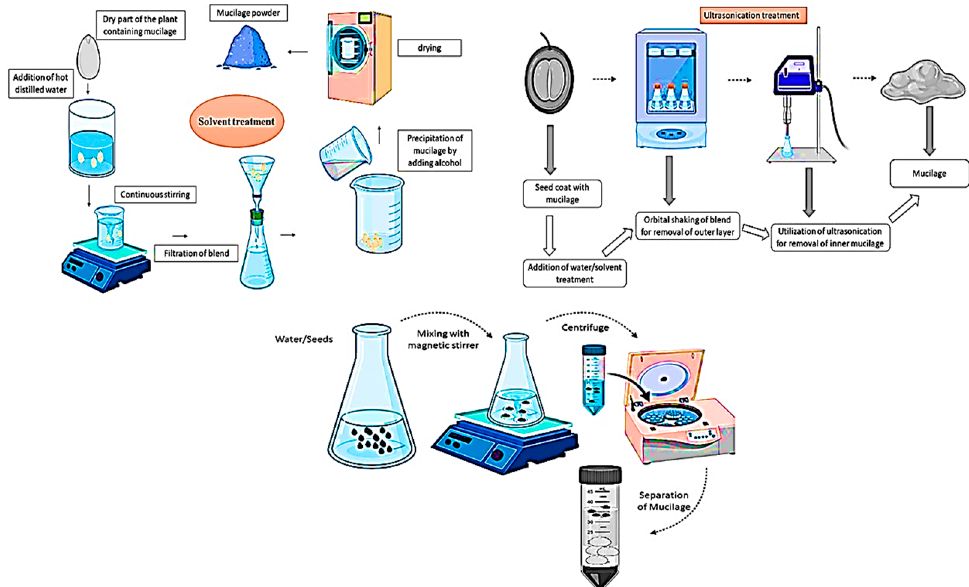
Figure 1. Extraction of mucilage from plant parts using solvent extraction, microwave assisted, and centrifugation process.